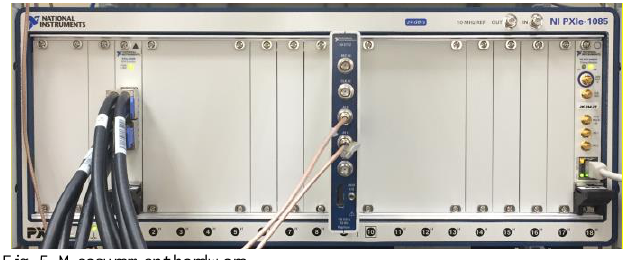
Fig. 5. Measurement hardware